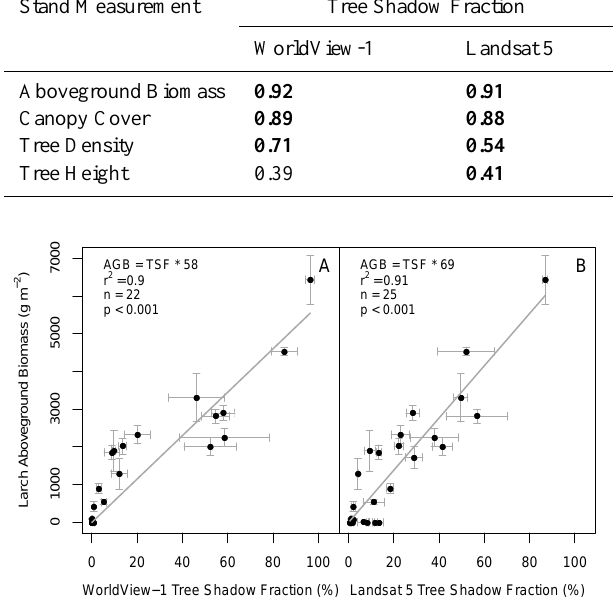
Fig. 3. Comparison of aboveground biomass from field estimates (AGB field ) with tree shadow fraction (TSF) derived from (a) WorldView-1 and (b) Landsat 5 satellite images. The points rep- resent site means ( ± 1 standard error). The relationship between AGB field and TSF is highly significant for both sensors ( r 2 ≈ 0 . 90, p < 0 . 001)